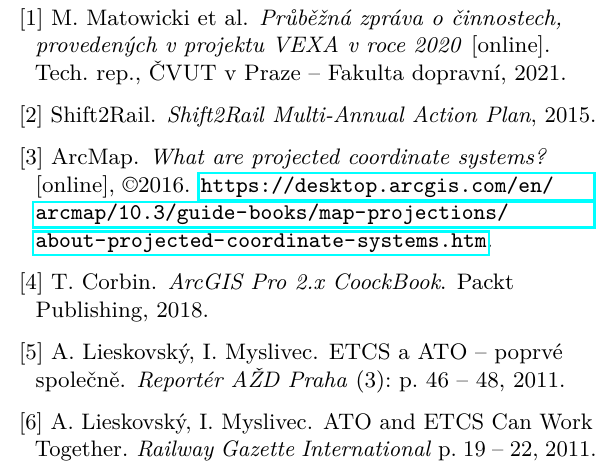
also make it possible to include among net entities those objects that are intended for comparison with the detected scene by the Map Matching